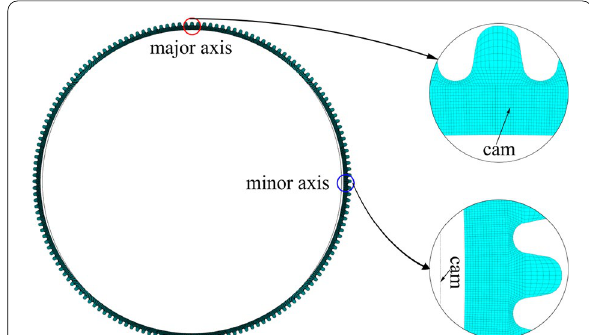
Figure 15 Ring-shaped flexspline assembling elliptical cam